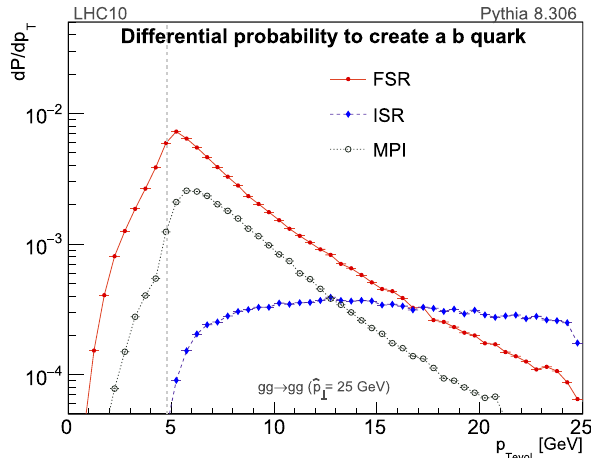
Fig. 4 Simple representations of different stages during the event evolution in Pythia